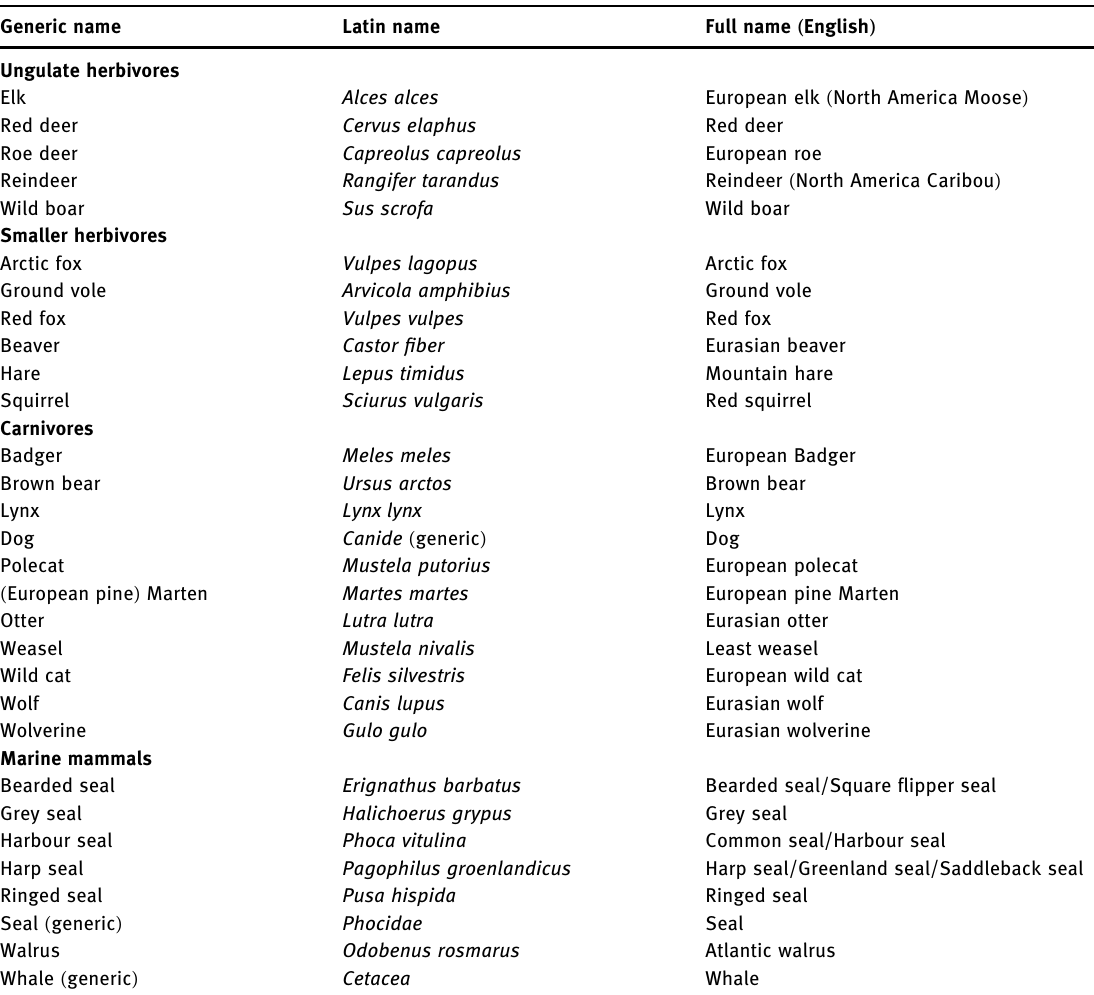
Table 2: Animal species names in English and Latin Generic